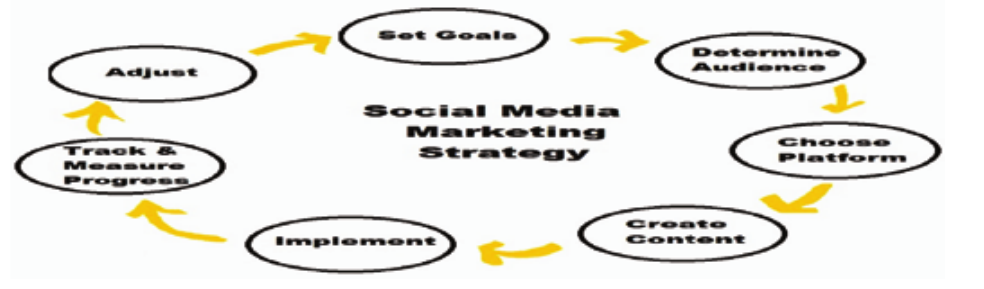
Source: Google Images (2017)